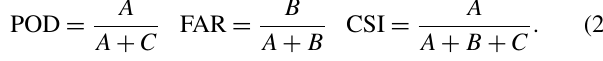
Figure 1. Fraction of DARDAR profiles identified by MSG-CPP high IWC mask v1. DARDAR profiles are sampled according to the maximum IWC value within the profile. The insert shows the same statistic but for different MSG-CPP parameter thresholds used in the MSG-CPP high IWC mask v1